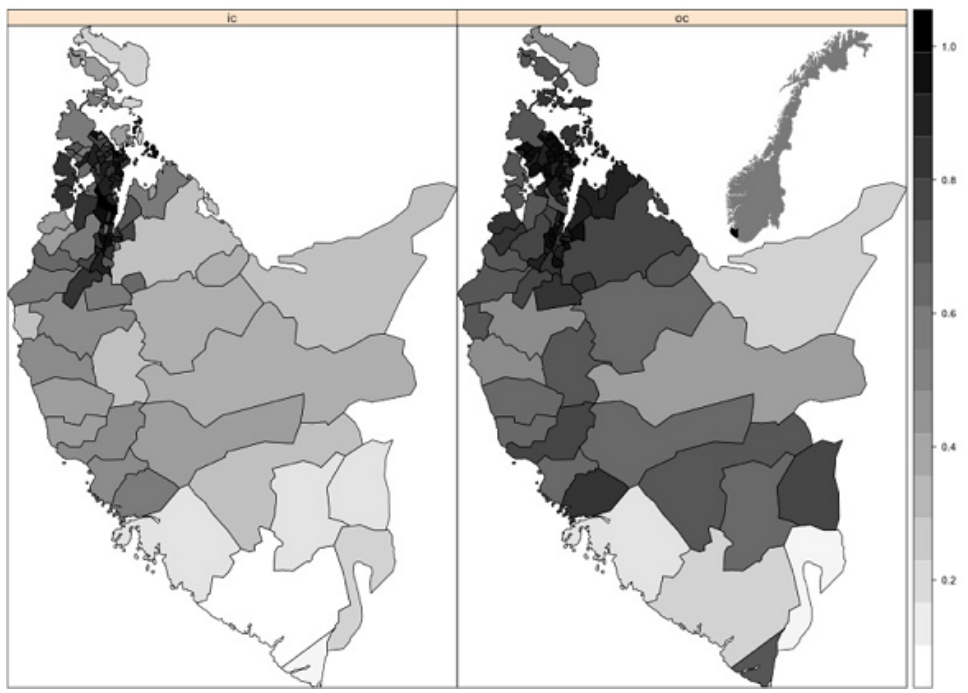
Figure 1: The 2006-values of IN-COM (left) and OUT-COM